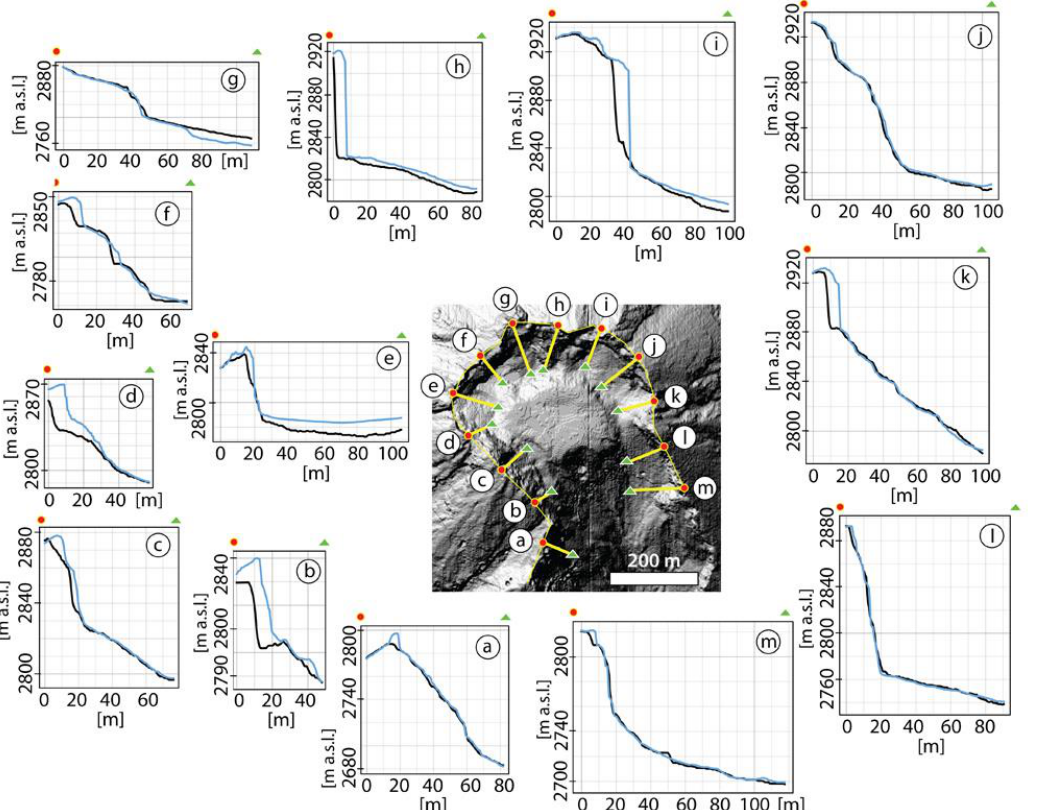
Figure 3. Cross-sections of the crater rim. The black line is the topography in 2012 as extracted from the LiDAR-DEM at 1 m horizontal resolution, and the blue line is the topography in 2014, extracted from the UAV-based photogrammetric